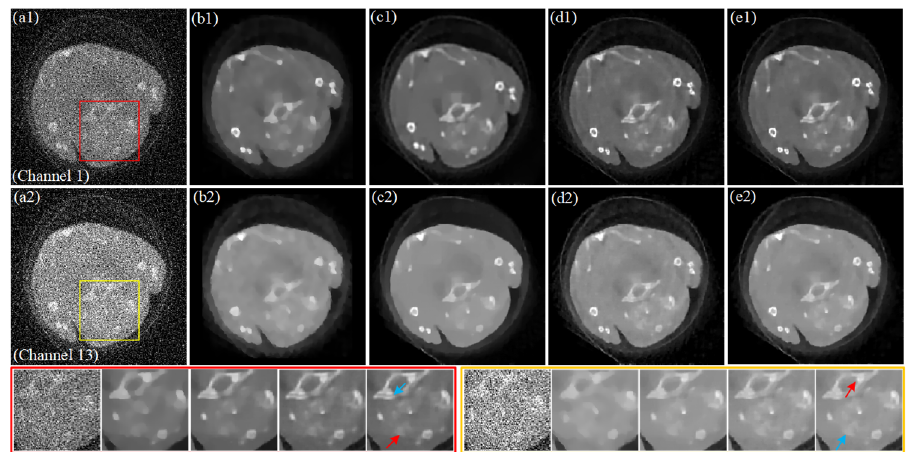
Figure 8. Reconstructed images from 120 projections using different methods. The first and the sec- ond rows are the results for channels 1 and 13, respectively. The last row is the corresponding ROIs from ( a1 )–( e2 ) in sequence. From left to right, the columns are FBP ( a ), TV ( b ), TVLR ( c ), TDL ( d ), and our algorithm ( e ). The display windows are [0, 0.1] cm − 1 and [0, 0.08] cm − 1 , respectively.